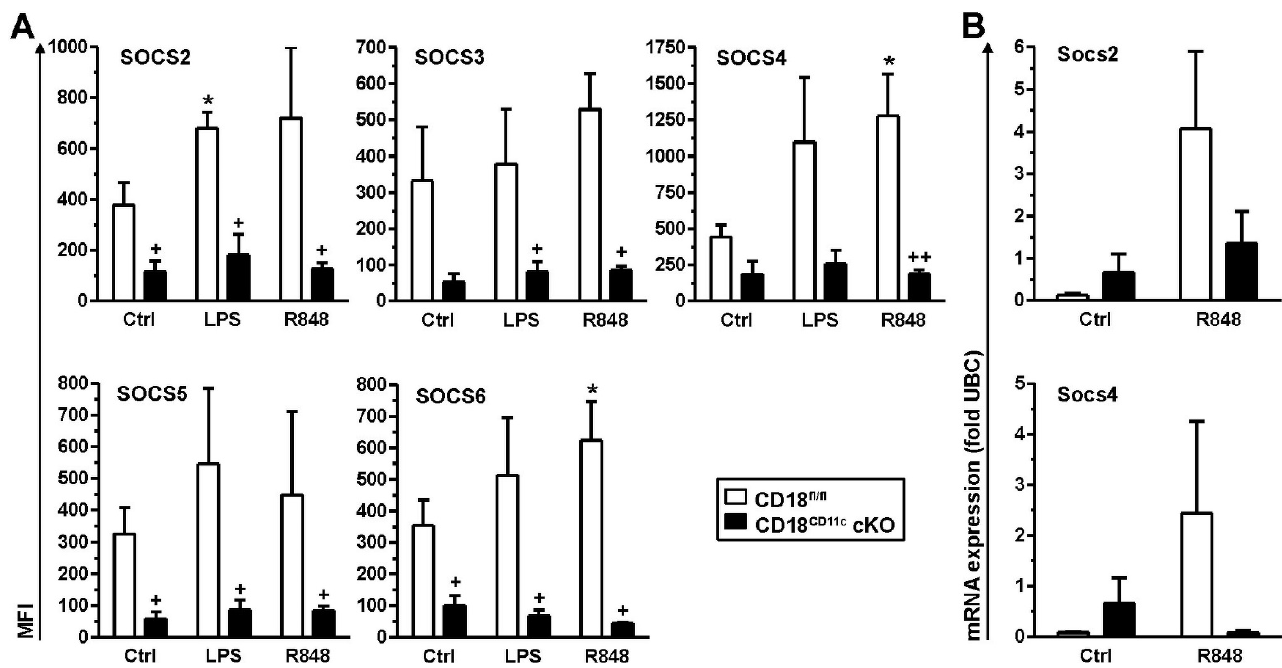
Figure 4. Impaired β 2 integrin expression in BMDCs results in attenuated SOCS protein levels. BMDCs (CD18 fl/fl and CD18 CD11c cKO) were stimulated overnight in parallel with LPS and R848 or were left untreated (Ctrl). ( A ) On the next day, SOCS protein expression was assessed on cytospins by immunofluorescence. Representative graphs are shown in Figure S5. Data denote SOCS protein expression (mean MFI ± SEM of 3–4 experiments). ( B ) Expression of SOCS mRNA species was monitored 4 h after onset of stimulation by real-time PCR and is given in relation to the expression of the housekeeping gene UBC (mean ± SEM of 3–4 experiments). ( B ) Statistical differences versus * corresponding Ctrl and + CD18 fl/fl at corresponding conditions are indicated (one-way ANOVA, Tukey test). * ,+ p < 0.05, ++ p <